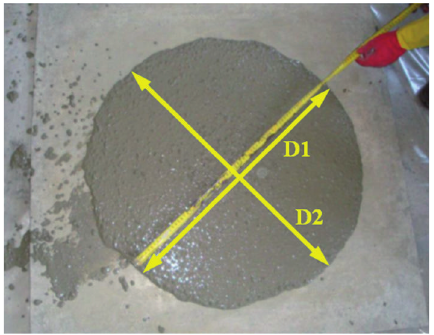
F 5: Slump �ow test of the used